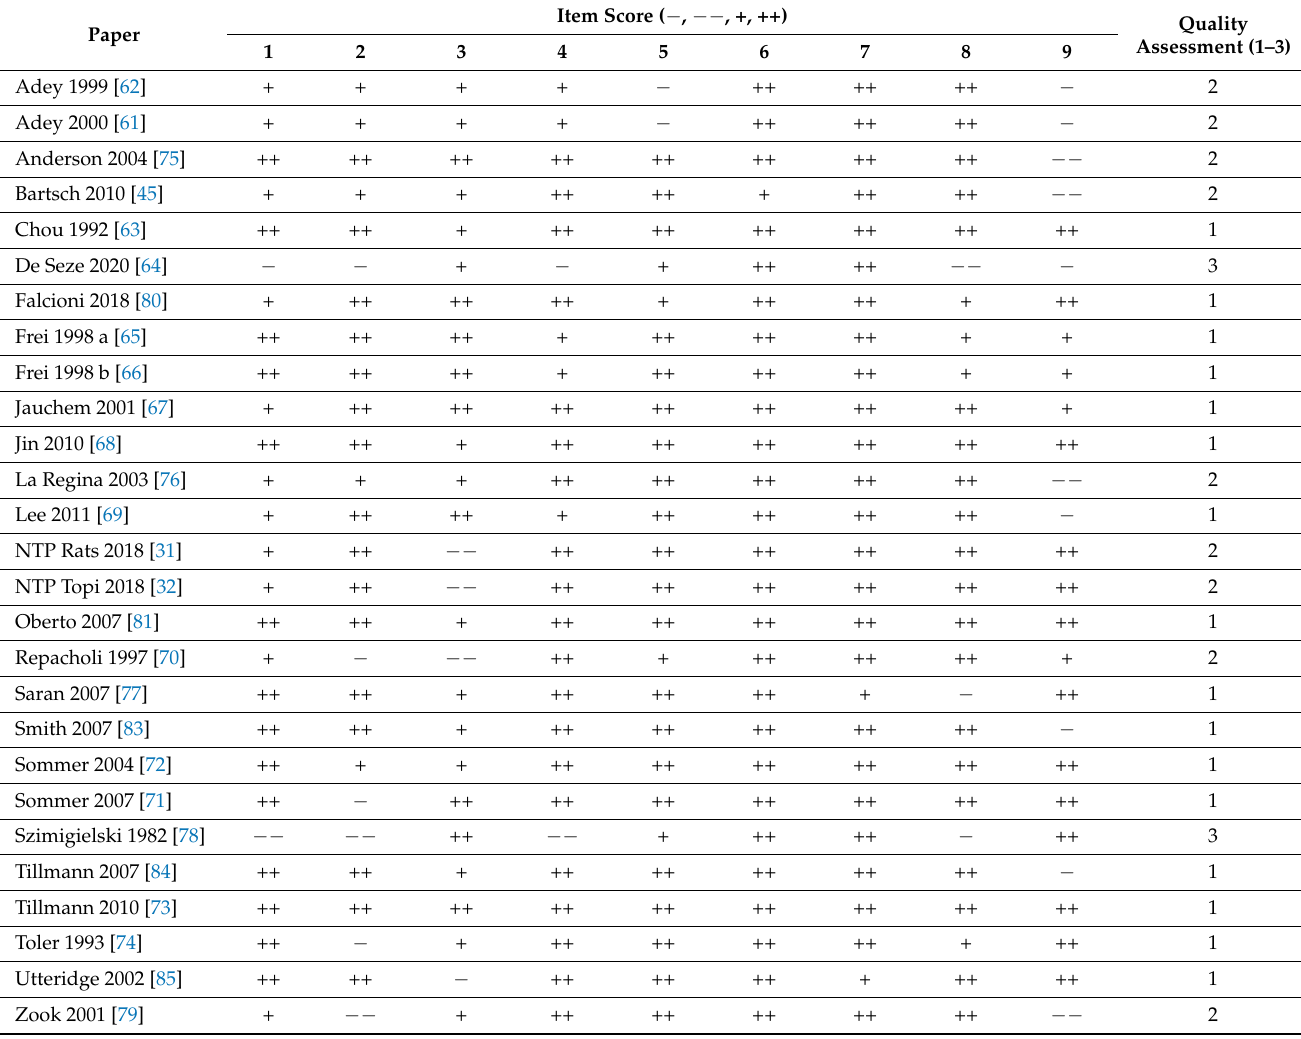
Table 2. RoB of the carcinogenesis studies and their related quality